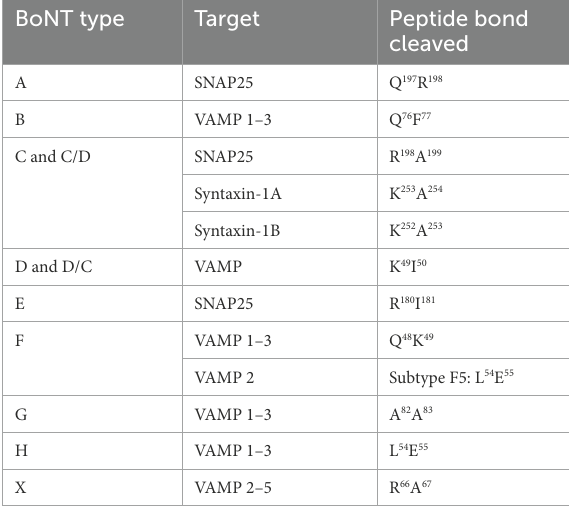
TABLE 1 BoNTs targets at nervous endings and their different sites of cleavage according to toxin